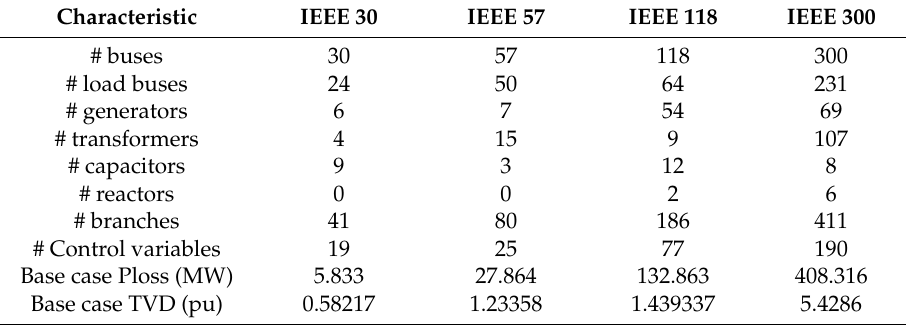
Table 1. Main characteristics of the test systems under study.